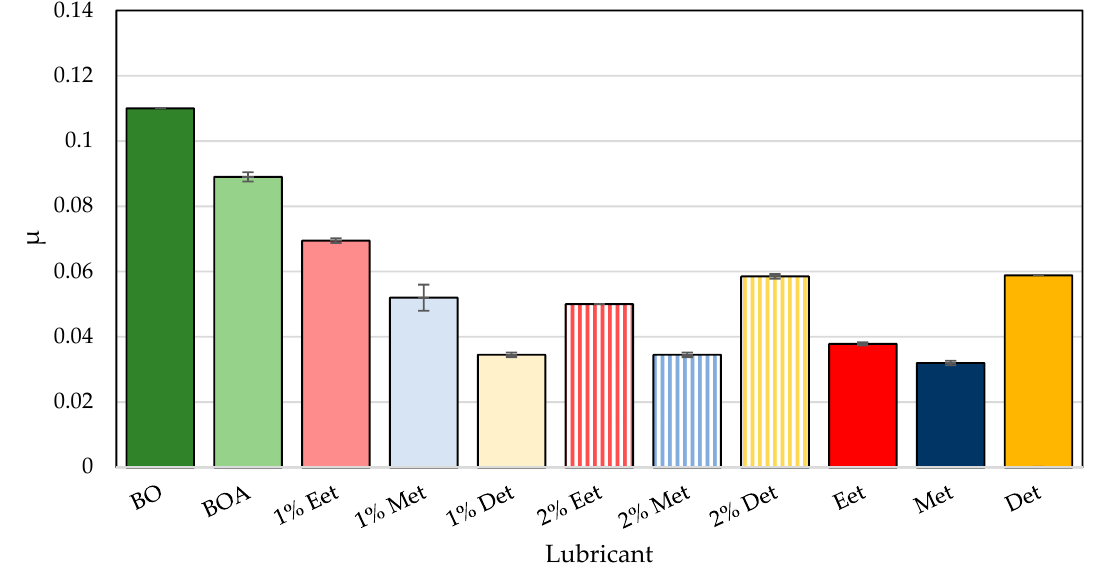
Figure 4. Average friction coefficients of steel–steel contact after tests lubricated with BO, BOA, neat PILs, and PIL blends 1 wt.% Eet + BO, 1 wt.% Met + BO, and 1 wt.% Det + BO.